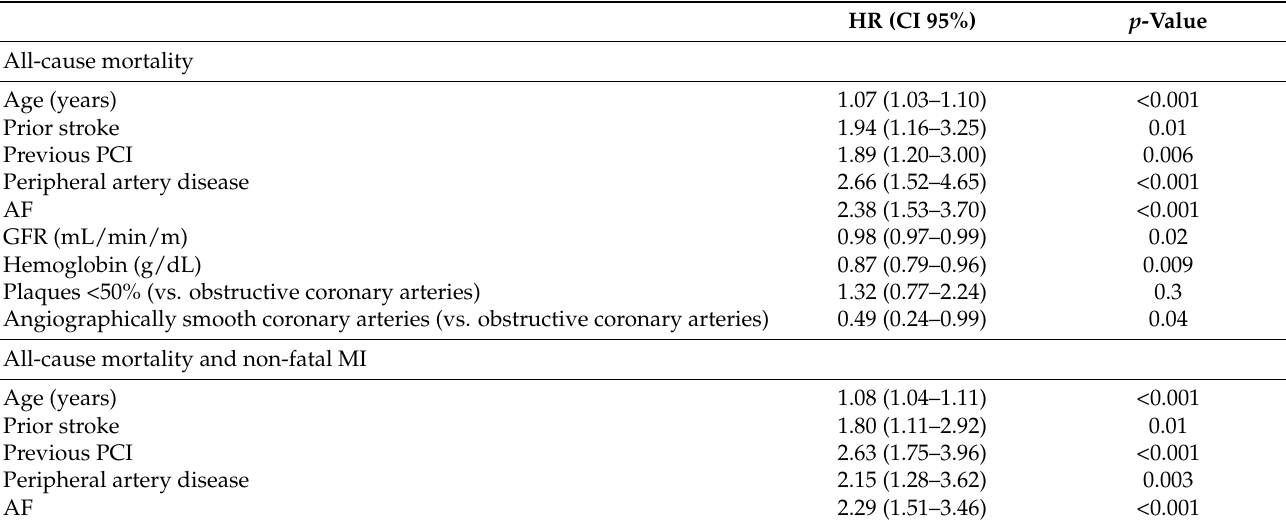
Table 6. All-cause mortality and MACE predictors. Multivariate